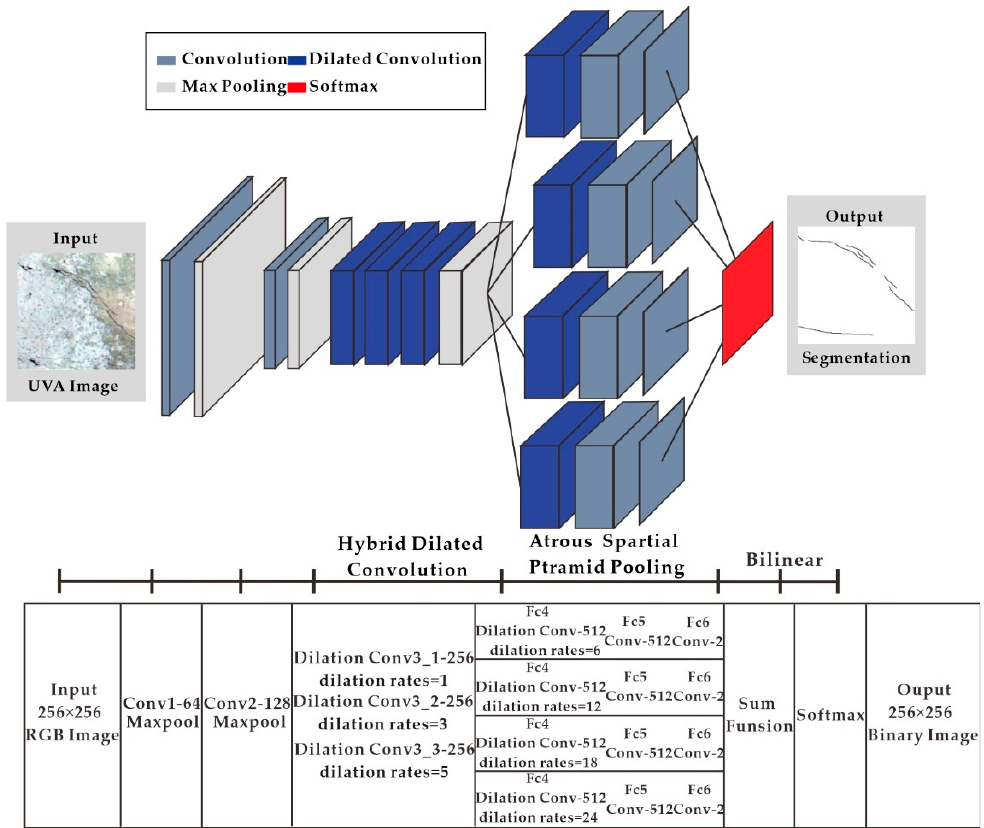
Figure 4. Network architecture.